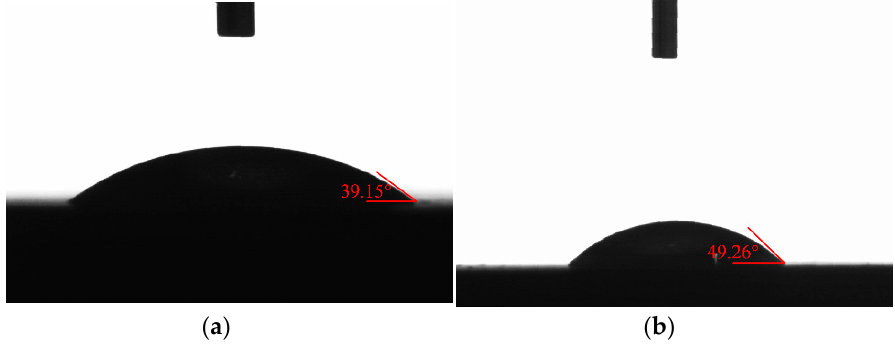
Figure 5. Contact angle between liquid and sample. ( a ) Contact angle between water and sample; ( b ) contact angle between silica sol and sample; water has a slightly better spreadability on the sample. Table 2. Driving force of different liquids.